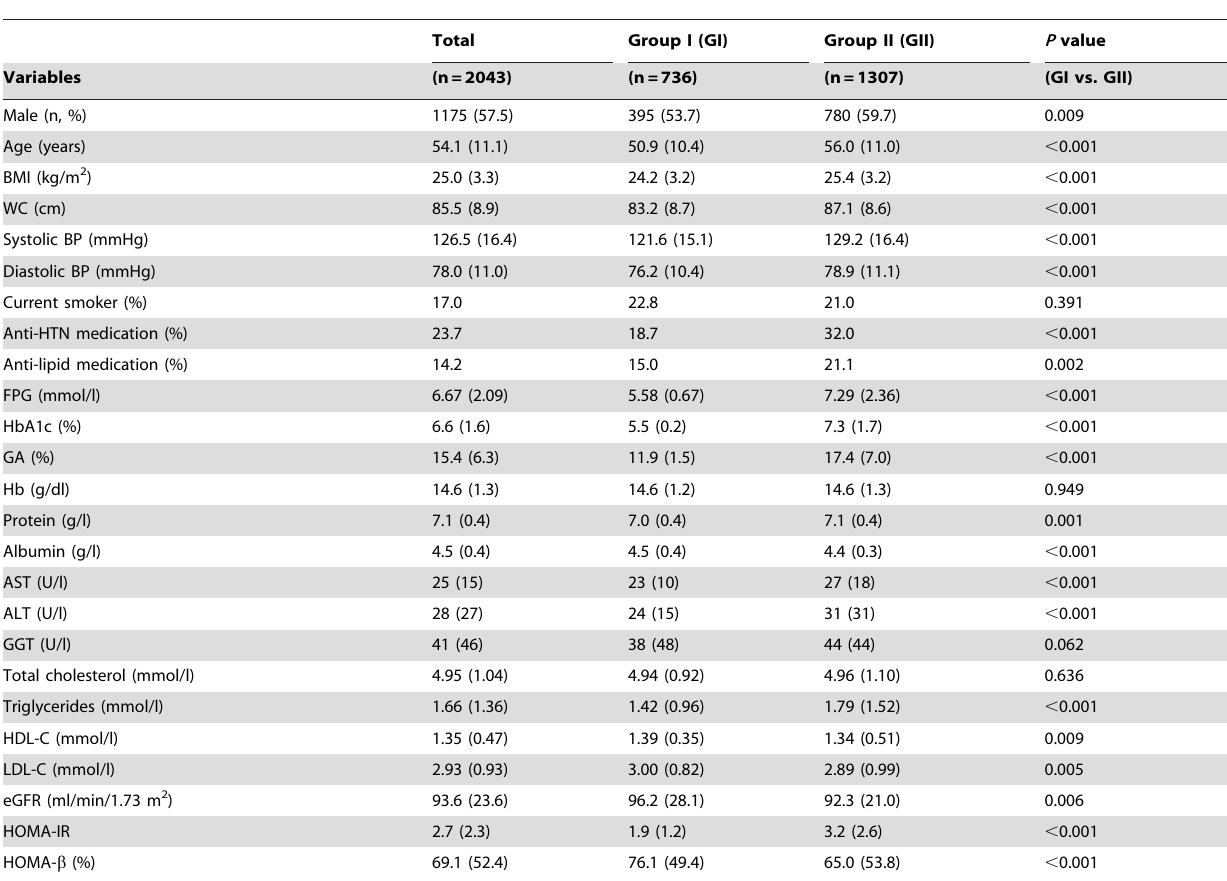
Table 1. Clinical and biochemical characteristics of the study